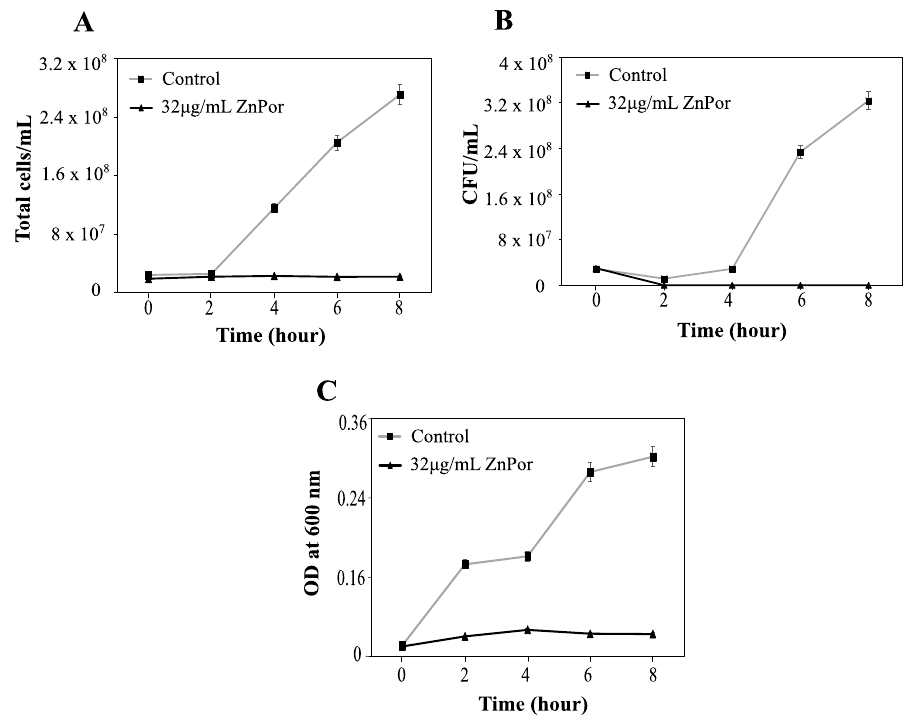
Figure 4. Viability and integrity of PsA after ZnPor treatment. PsA grown overnight in MSG were diluted in fresh MSG to 0.15 OD. ZnPor was added at a concentration of 32 µg/mL; control was without ZnPor. Samples were measured at various time intervals ( x -axis). PsA cells were washed to remove extracellular ZnPor. The same cell suspensions were sampled for all three measurements. ( A ) Total cell counts (cells / mL) were calculated (Petro ff –Hausser cell-counting chamber). ( B ) Viable cell counts (CFU per mL) were determined by plating the same cells on LB agar medium. ( C ) Cell suspensions (from A , B ) were measured (at 600 nm) to determine whether cells had lysed or remained intact. All data points represent mean ± SD of three independent experiments ( n =